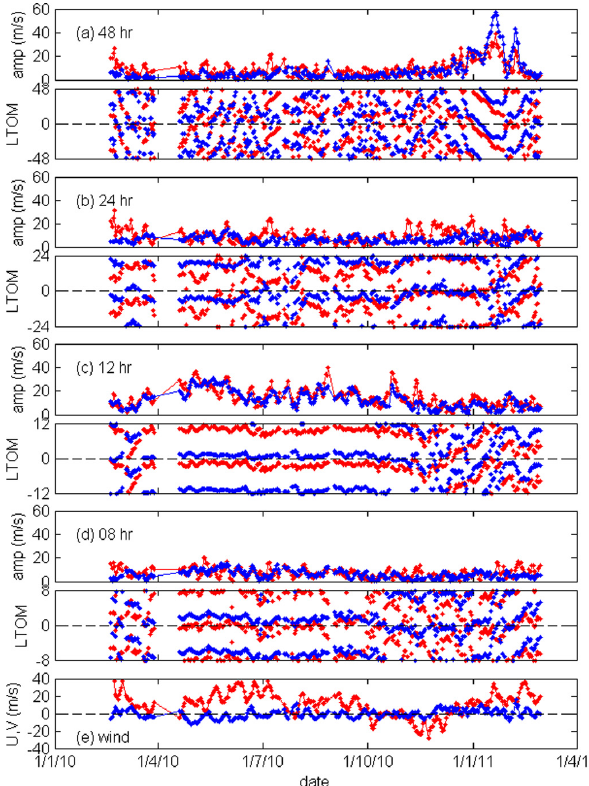
Fig. 5. Amplitude and phase of the daily fitted 48-h (a) , 24-h (b) , 12-h (c) , and 8-h (d) waves, and the background wind (e) . The zonal component (positive eastward) is shown in red and the meridional component (positive northward) is shown in blue. Wave phases are plotted as local time of maximum (LTOM) and are repeated over two cycles to show coherence.